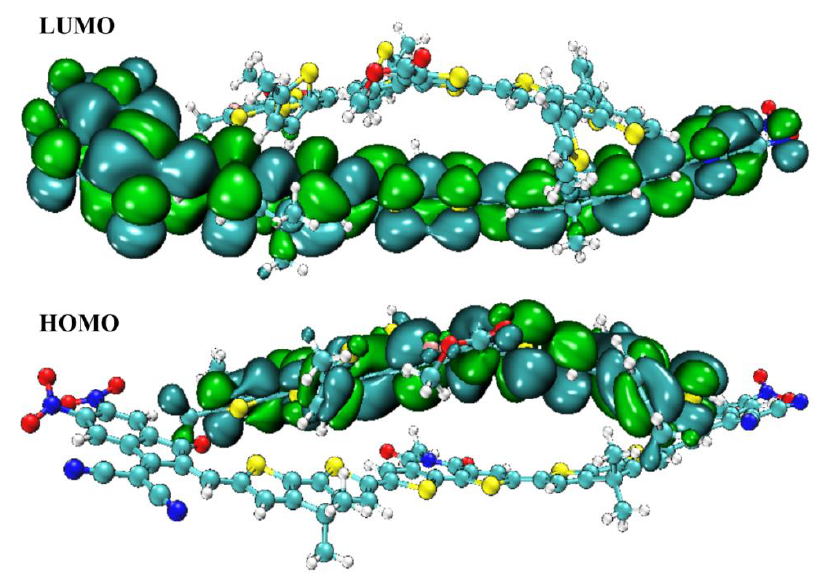
Figure 14. HOMO and LUMO distribution on the blend.